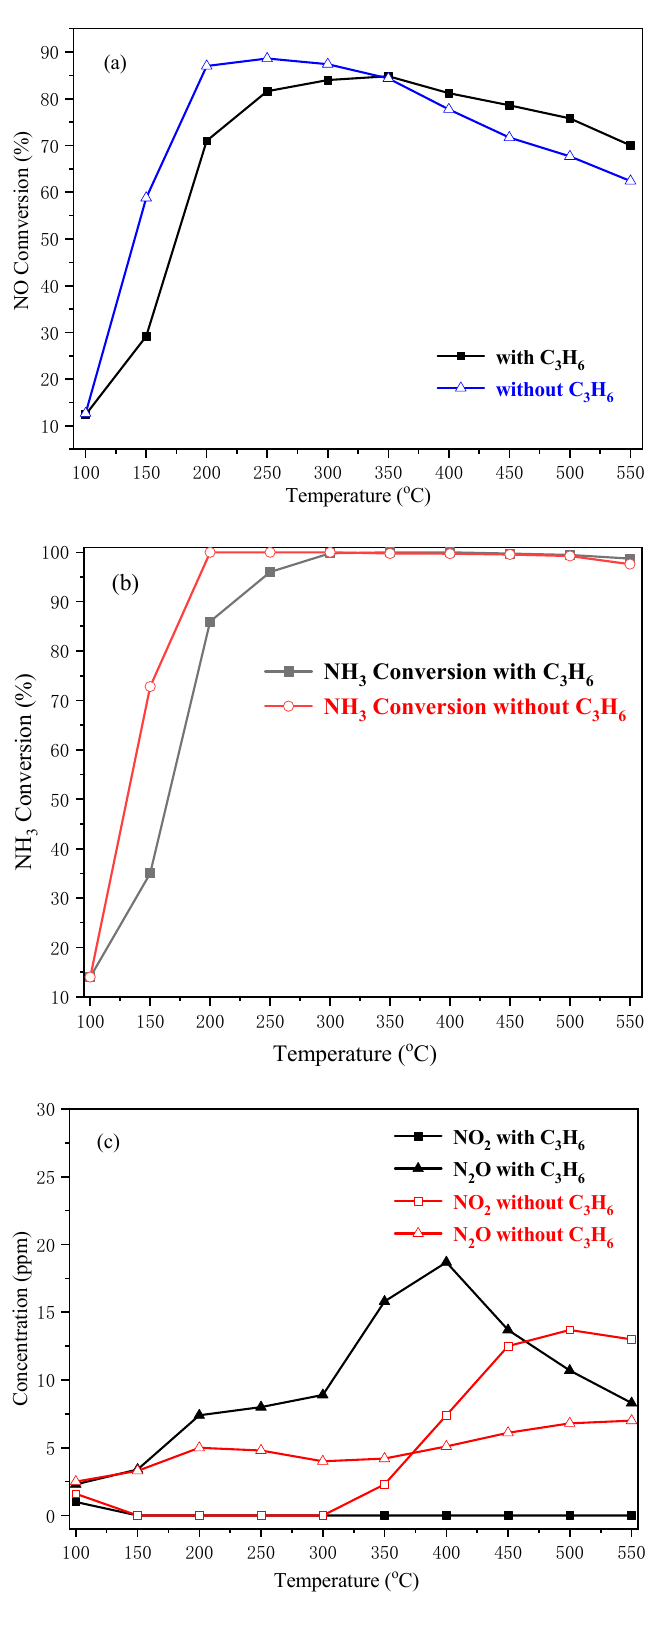
Figure 3. The SCR activities over Cu/SAPO-34 catalysts with or without C 3 H 6 . ( a ) The NO con- version; ( b ) the NH 3 conversion; and ( c ) the concentrations of NO 2 and N 2 O. Reaction condition: 500 ppm NO, 500 ppm NH 3 , 500 ppm C 3 H 6 , 10% O 2 , with N 2 as balance gas. GHSV= 300,000 h − 1